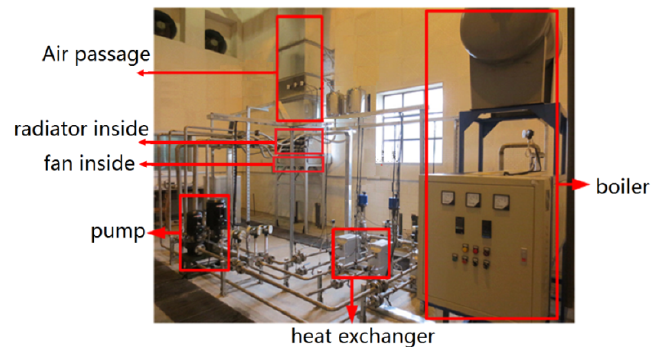
Fig. 8. The test bench.